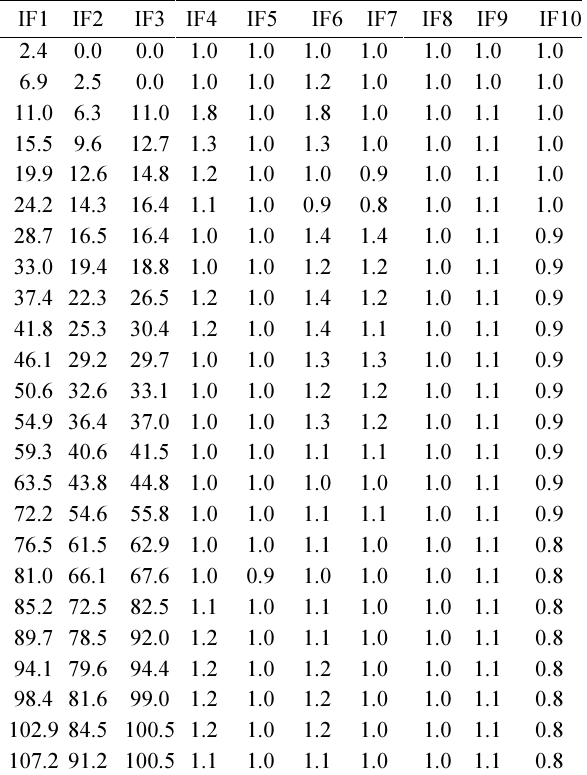
Table 4. Input data for project 2 with 24 completion